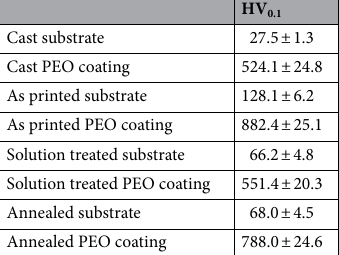
Table 3. Vickers micro-hardness (100 g load) obtained on the substrate and on the cross section of the PEO coatings in the different samples.